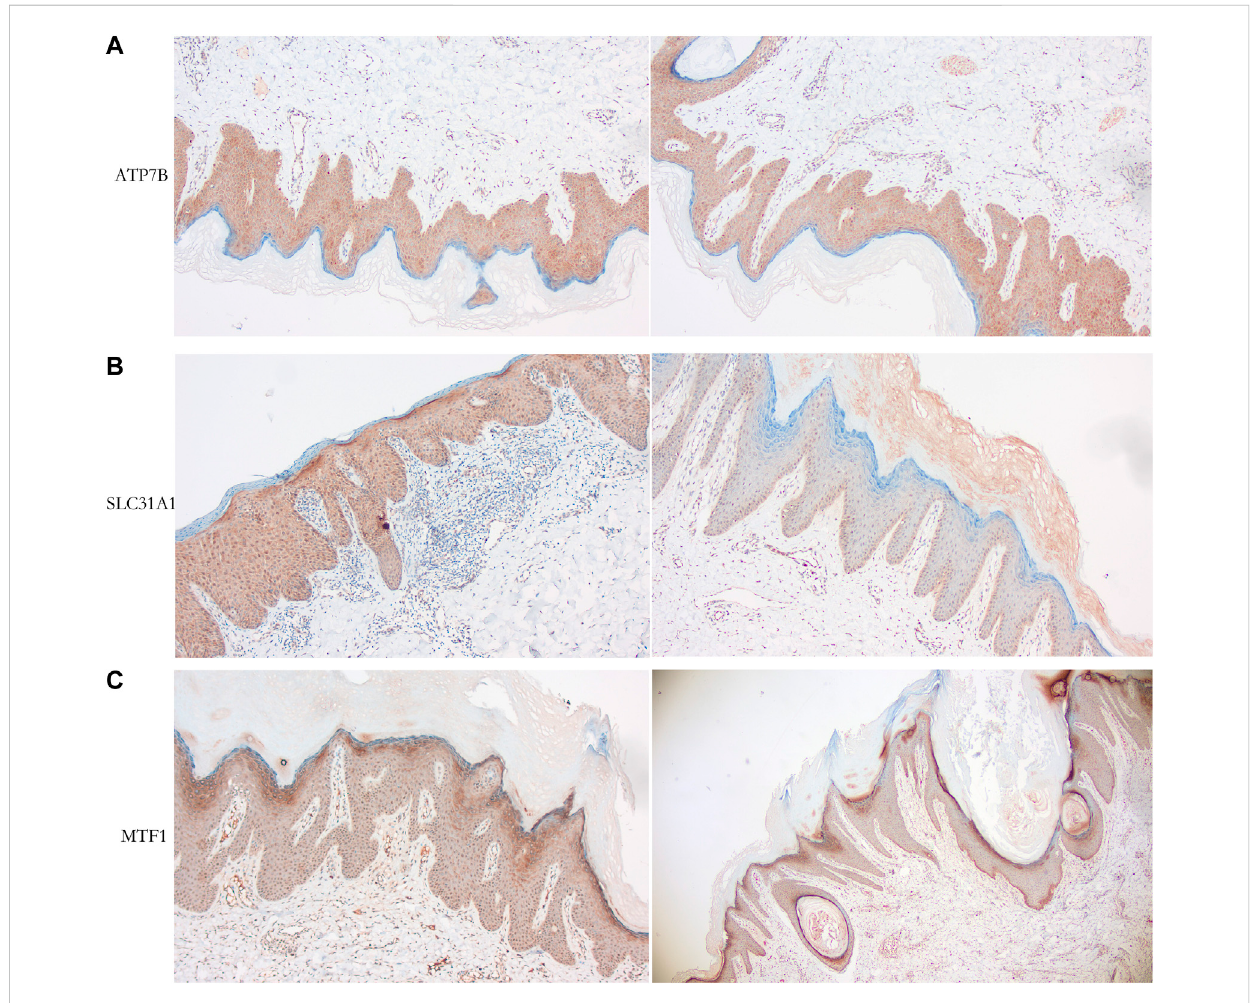
FIGURE 10 Immunohistochemical analysis of psoriasiss-related proteins. (A) Cytoplastic expression of ATP7B (tan particles of positive expressive object). (B) Cytoplastic expressionofSLC31A1 (tanparticlesofpositive expressiveobject). (C) ExpressionofMTF1 (tanparticlesofpositive expressiveobject) stainthe cytoplasm of epidermal insuf fi ciency or hyperkeratosis